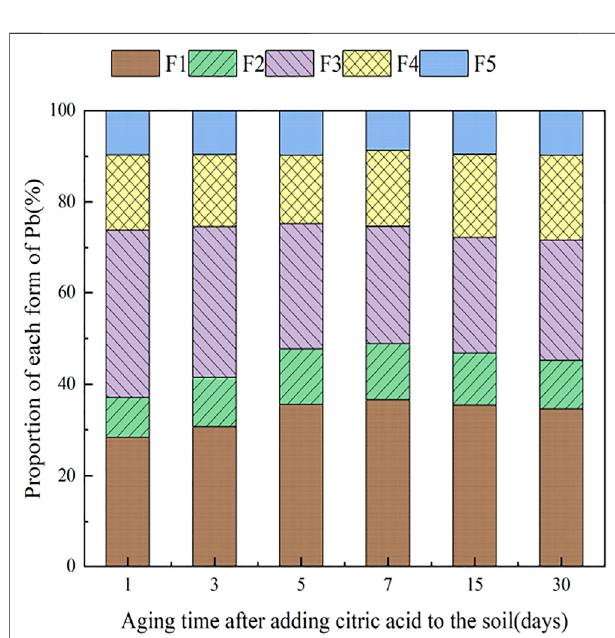
FIGURE 12 | Distribution of Pb in Pb-400 – contaminated soil after adding citric acid.